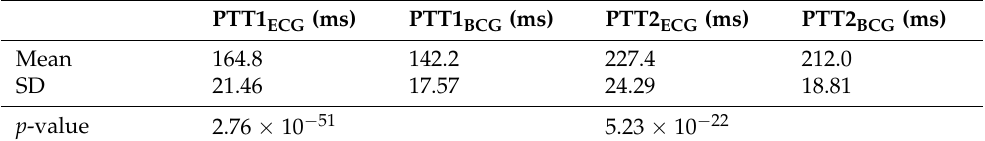
Table 6. The statistic of total PTT1 and PTT2 measured by reference and proposed methods. PTT1 ECG (ms) PTT1 BCG (ms) PTT2 ECG (ms) PTT2 BCG (ms) Mean 164.8 142.2 227.4 212.0 SD 21.46 17.57 24.29 18.81 p -value 2.76 × 10 − 51 5.23 × 10 − 22